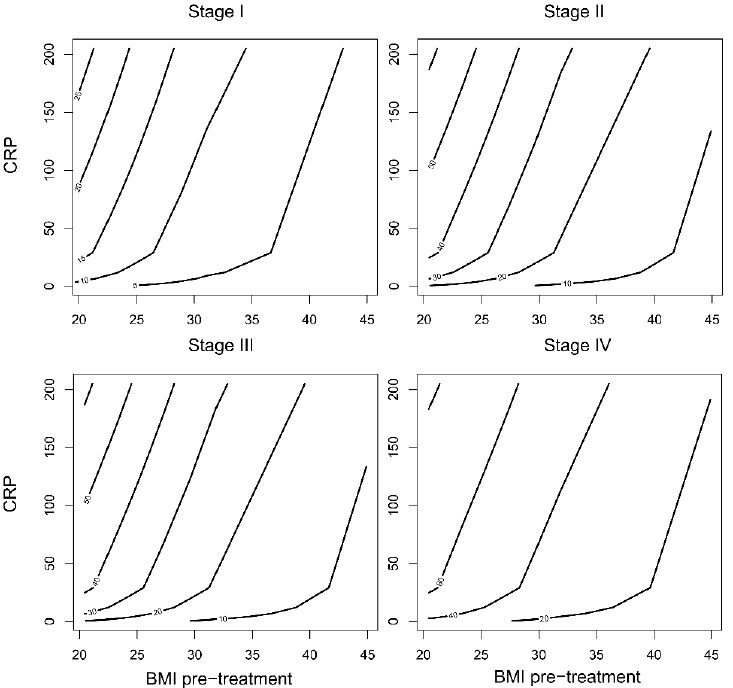
Figure 5. Risk estimation charts. The dataset was simultaneously partitioned by deciles of initial BMI and CRP, yielding 100 cells. In each cell the risk of recurrence over 2 person-years was calculated from the reduced Cox regression model hazard rates, for each of the stages at diagnosis. The contours delineate the risk of recurrence depending on the initial BMI and CRP measured at any timepoint, in percent.